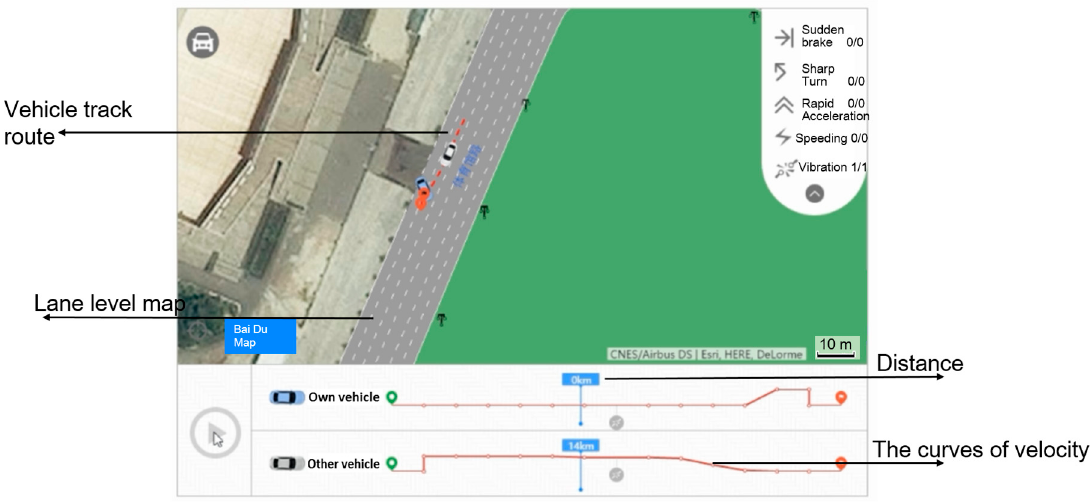
Figure 10. Reconstruction of the accident